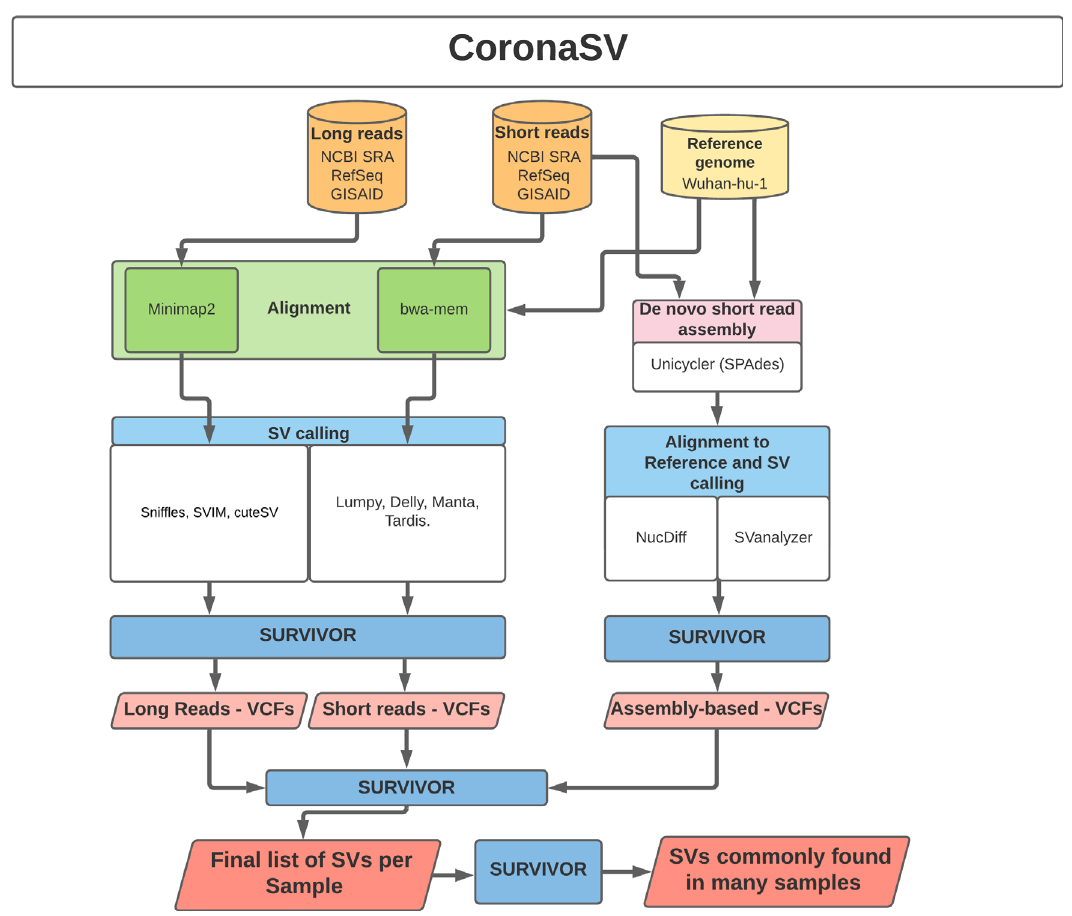
Figure 3. Illustration of CoronaSV software implementation. Illustration of the CoronaSV package workflow that takesSARS-CoV-2short and longreaddata types alongwith aSARS-CoV-2reference genome as inputand generates a set of commonly found